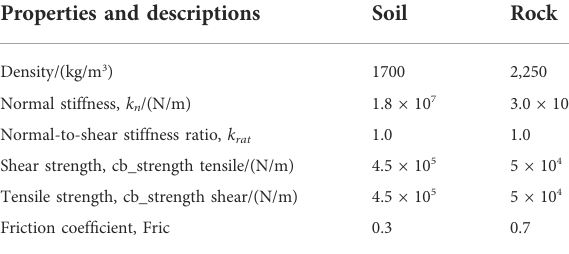
TABLE 1 Mesoscopic parameters of the soil and rock